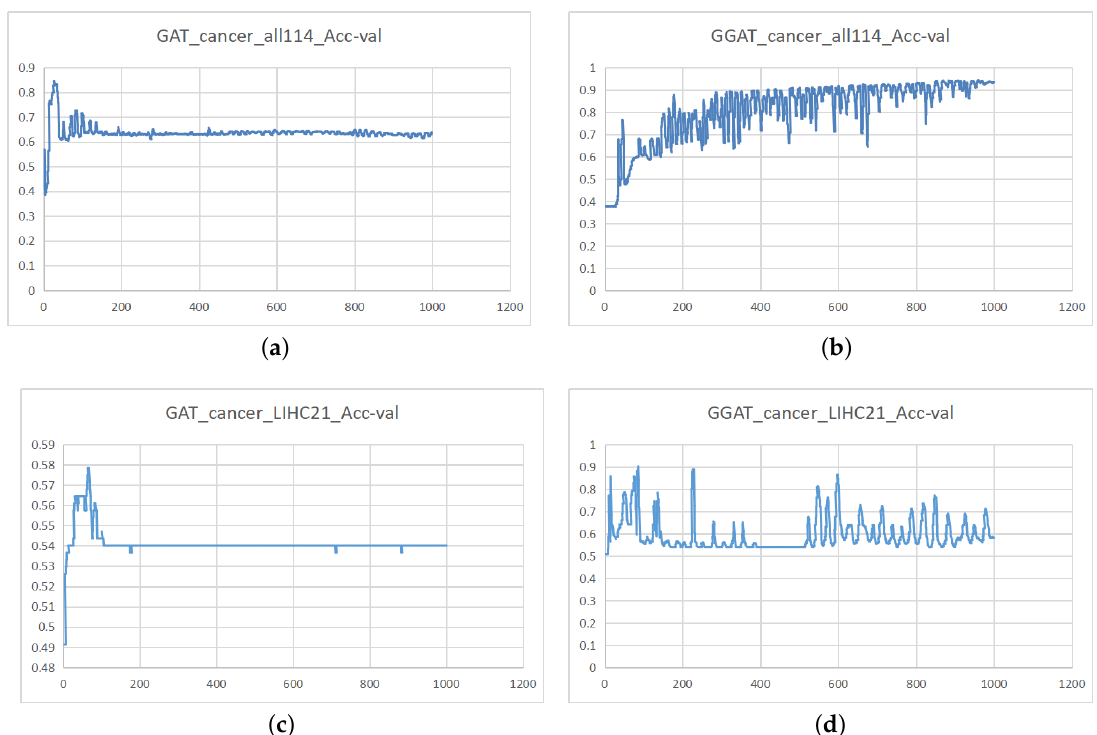
Figure 4. Acc_val of GAT ( left ) and GGAT ( right ) When Training on Cancer_all and LIHC(21). (2) The AMs of GAT and GGAT can act as feature